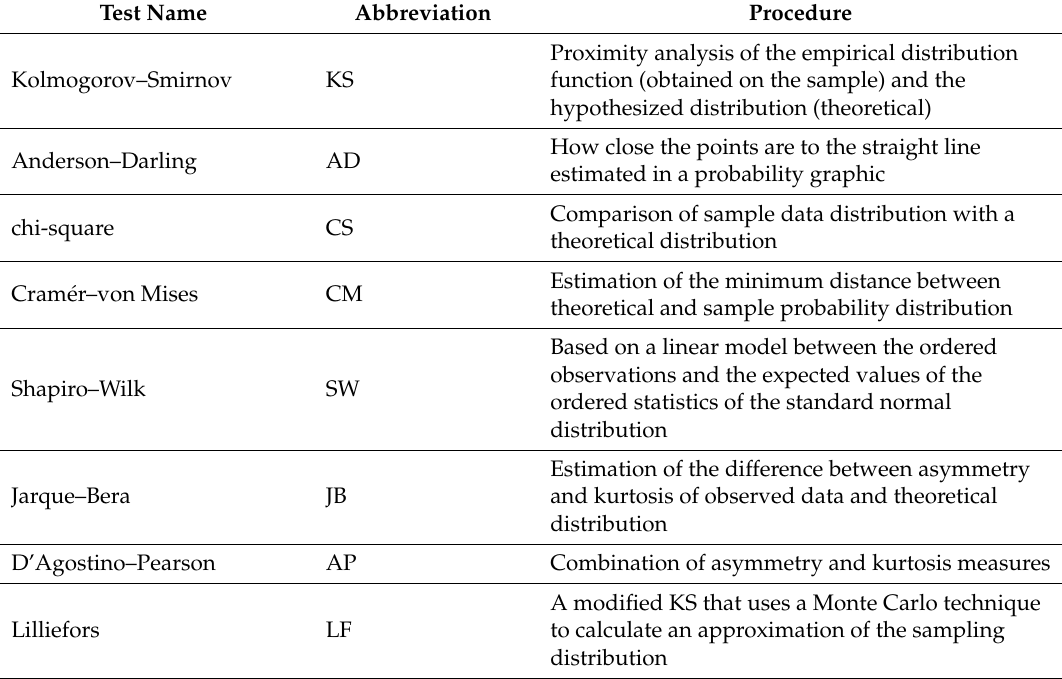
Table 1. The goodness-of-fit tests: